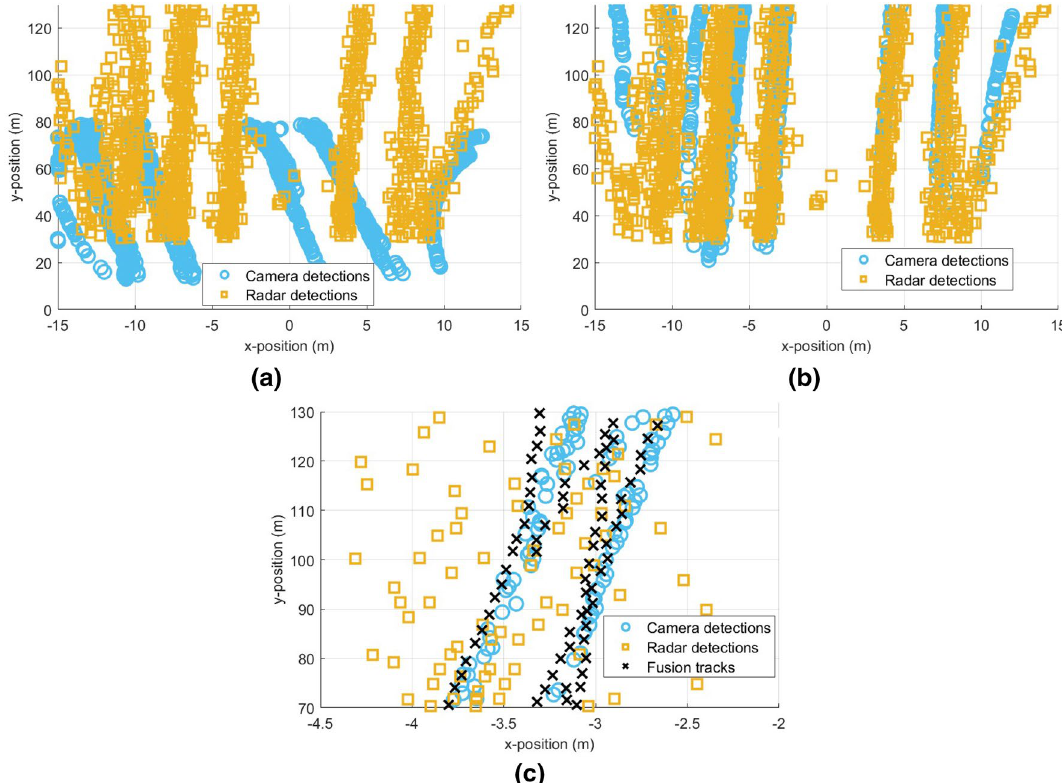
Figure 10. Radar-camera calibration. ( a ) Detections of car flows before sensor calibration in radar and camera LCs, the axes of the two LC systems are overlapped and drawn together, ( b ) Detections of car flows after sensor calibration in UCS, ( c ) Car tracks outputed by fusion Kalman filter after sensor calibration in zoomed-in UCS.